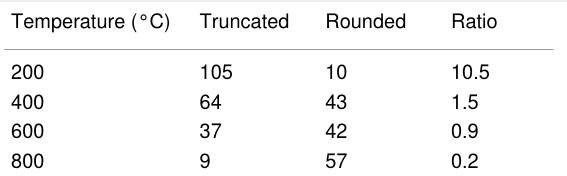
Table 1: Ratio of truncated to rounded particles depending on the annealing temperature.